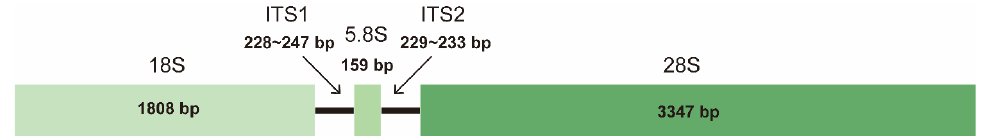
Figure 1. The structure between the 45S rDNA of P. pseudocerasus and its relatives.